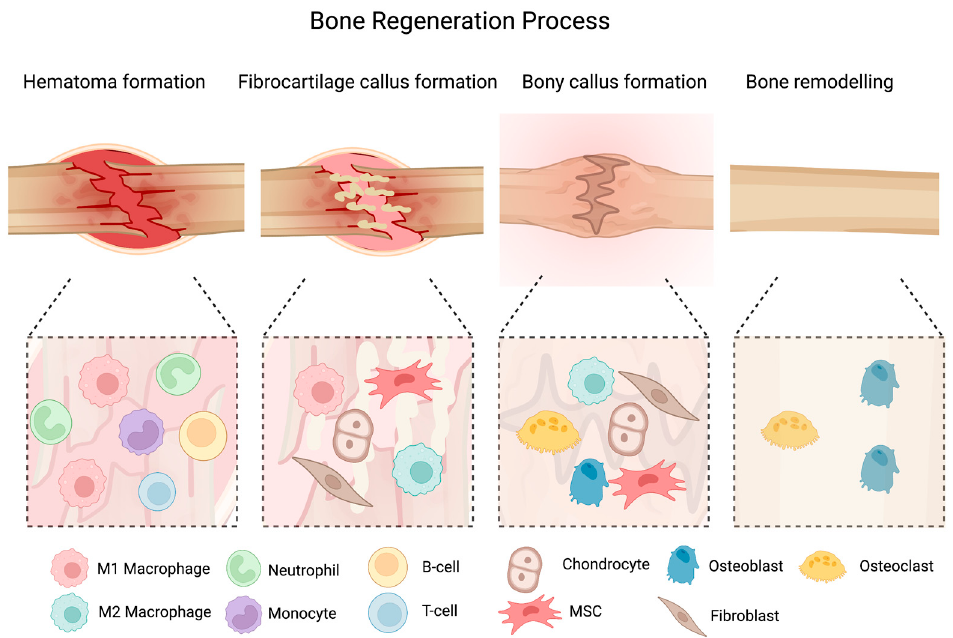
Figure 1. The figure of bone (fracture) healing process. The several phases of bone regeneration are presented, from the initial hematoma formation phase to callus formation and subsequent remodeling. At each phase, the major cell populations are indicated. Created with BioRender.com.